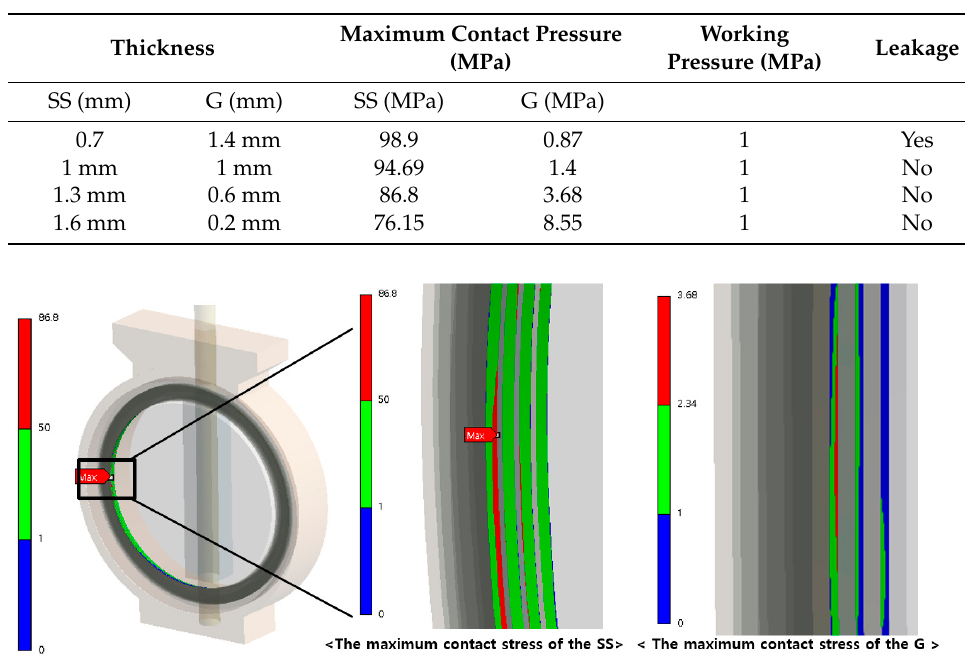
Figure 21. Contact stress distribution of design 3.